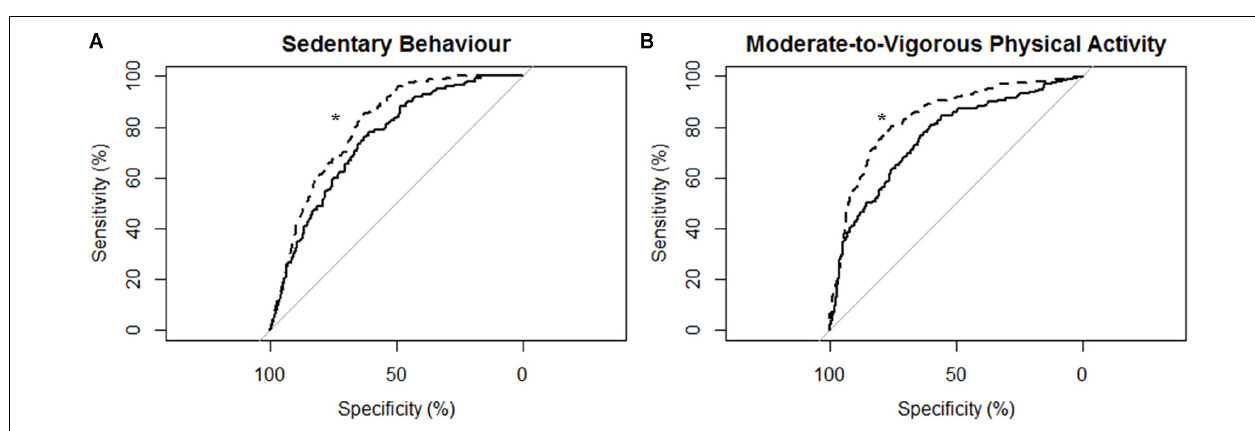
FIGURE 4 | Receiver operating characteristic (ROC) curves and corresponding area under the curves (with 95% confidence interval; AUC) for participants with moderate-to-severe stroke ( N = 14) with the MotionWatch8 (MW8) placed on either the non-affected side or the stroke affected side. (A) ROC curve for sedentary behavior with MW8 placed on the non-affected side (–) vs. affected side (- - -). We found there was moderate diagnostic accuracy for the non-affected side (AUC = 0.748; 95% CI: [0.708–0.788]), and moderate diagnostic accuracy for the affected side (AUC = 0.804; 95% CI: [0.771–0.837]). (B) ROC curve for moderate-to-vigorous physical activity with MW8 placed on the non-affected side (–) vs. affected side (- - -). We found there was moderate diagnostic accuracy for the non-affected side (AUC = 0.760; 95% CI: [0.723–0.797]), and moderate diagnostic accuracy for the affected side (AUC = 0.839; 95% CI: [0.809–0.869]). ∗ Significant difference in diagnostic accuracy between ROC curves (DeLong et al.,